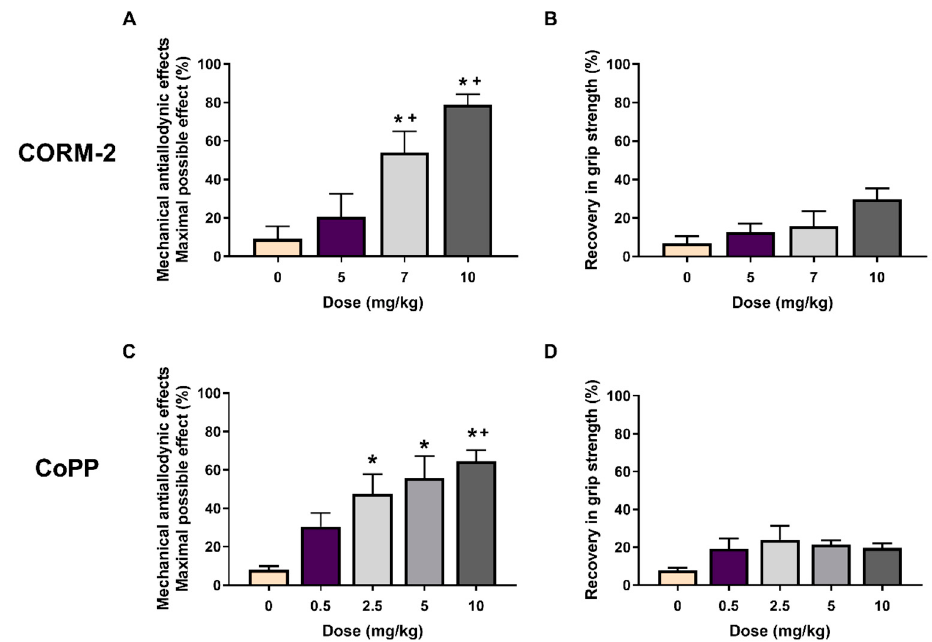
Figure 2. CORM-2 or CoPP treatments inhibited the mechanical allodynia but not the grip strength deficit induced by MIA in a dose-dependent manner. Mechanical antiallodynic ( A , C ) and the recovery in grip strength ( B , D ) effects induced by different doses of CORM-2 or CoPP (mg/kg) are represented. For each test and treatment, * indicates significant differences vs. vehicle (0 mg/kg)-treated mice and + vs. the effect produced by low doses of CORM-2 (5 mg/kg) or CoPP (0.5 mg/kg) ( p < 0.05; one-way ANOVA, followed by the Student–Newman–Keuls test). Data are expressed as the mean values of the maximal possible effect (%) for the mechanical allodynia and the recovery in grip strength (%) ± SEM; n = 6 animals per dose and treatment.